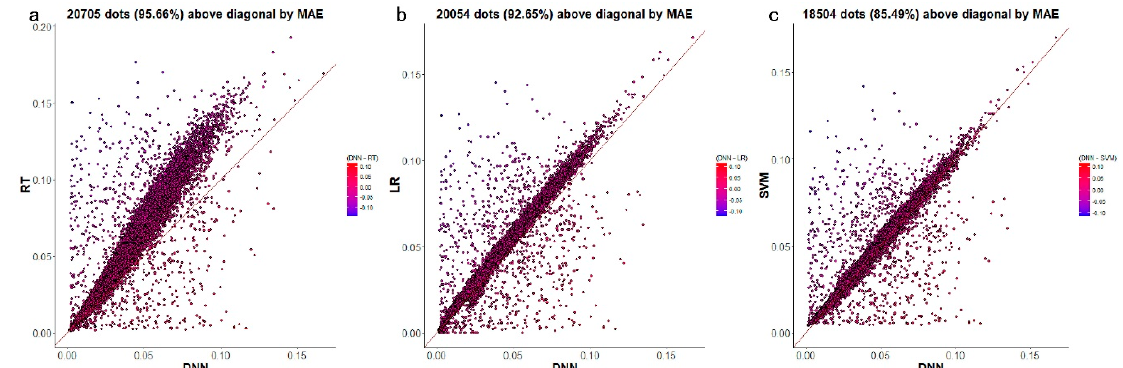
Figure 5. The predictive MAE of each target gene by D-GPM compared with RT, LR, and SVM for MBV-te. Each dot represents one of the 21,645 target genes. The x-axis is the MAE of each target gene obtained by D-GPM, and the y-axis is the MAE of each target gene obtained by the other machine learning method. The dots above the diagonal indicate that D-GPM achieves lower MAE compared with the other method. ( a ) D-GPM versus RT. ( b ) D-GPM versus LR. ( c ) D-GPM versus SVM. RT performs significantly worse than the other methods in terms of the MAE. One possible promoter methylation of the landmark and target genes based on the MBV-te [32].